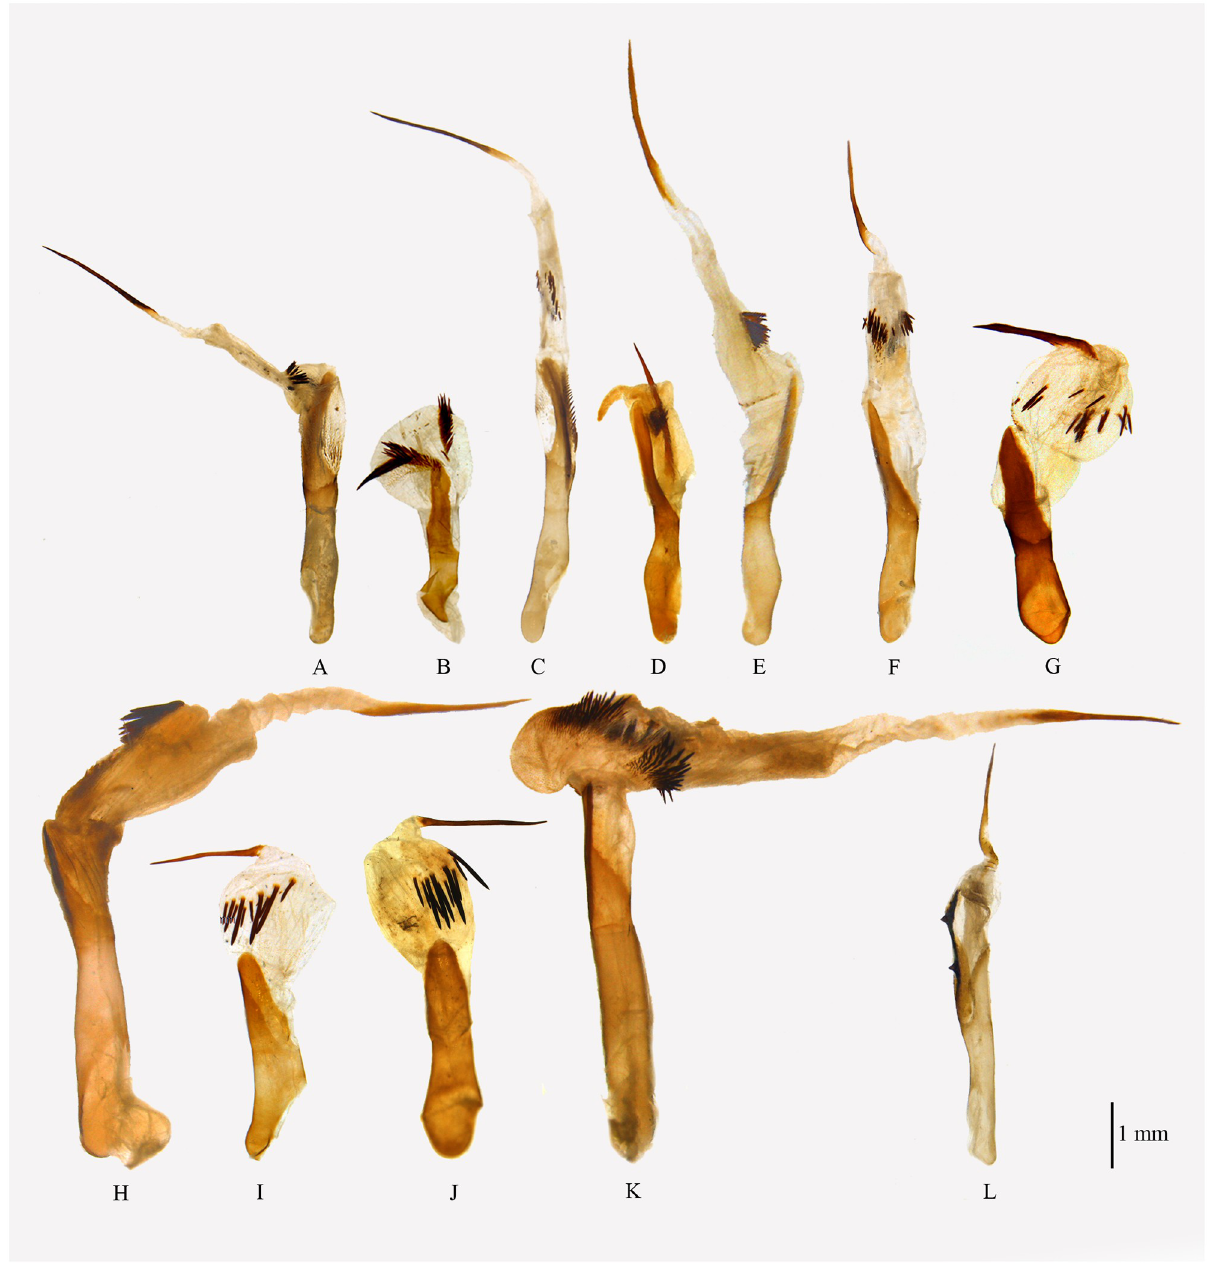
Fig 5. Aedeagus of Psyra species . A. P . gracilis B. P . angulifera C. P . cuneata D. P . szetschwana E. P . fulvaria F. P . similaria G. P . similaria (Dihang Dibang Biosphere Reserve morph) H. P . crypta I. P . debilis debilis J. P . debilis indica K. P . spurcataria L. P . falcipennis .